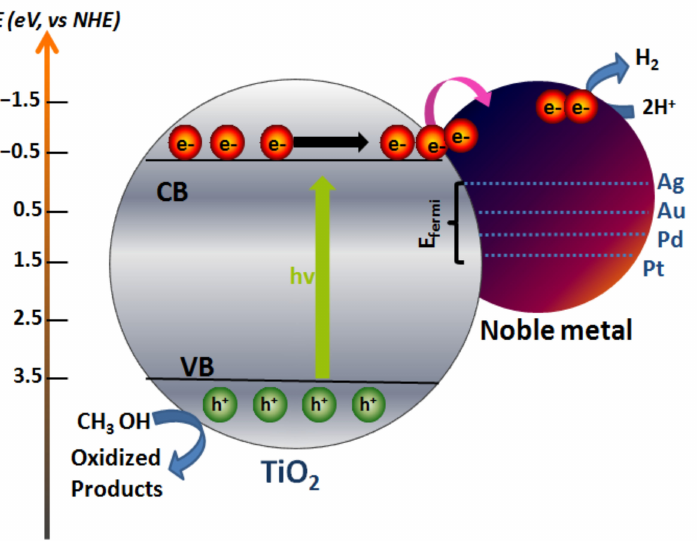
Figure 6. Proposed photocatalytic mechanism for the H 2 production by the FSP-made NM 0 -TiO 2